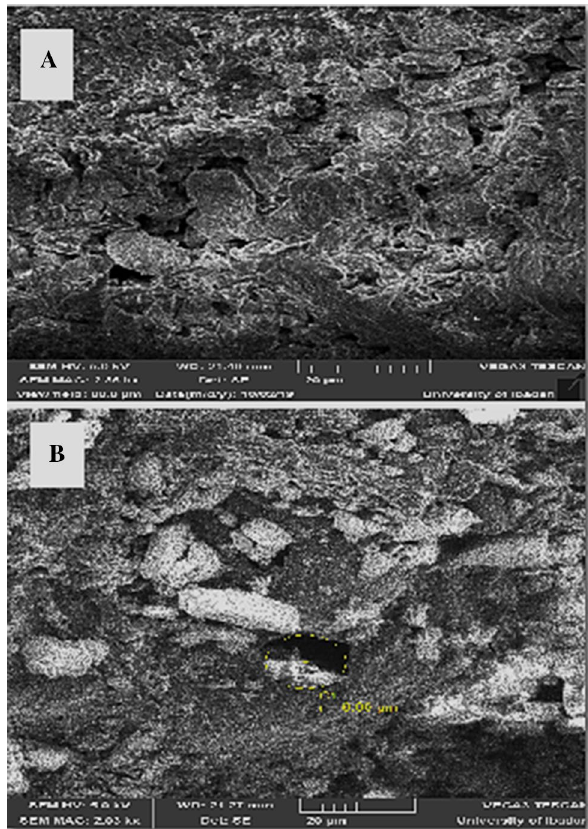
Fig. 1 SEM micrograph of FBPC at magnifications a 1000X and b